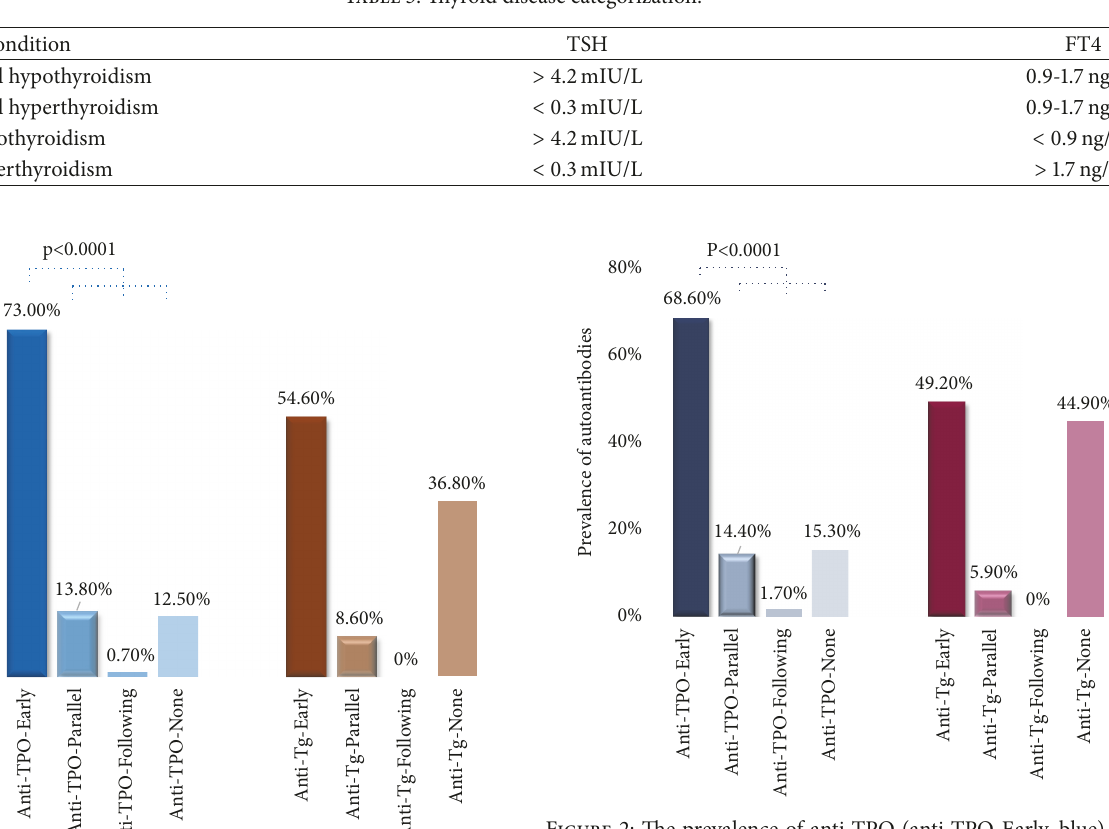
Table 3: Thyroid disease categorization.